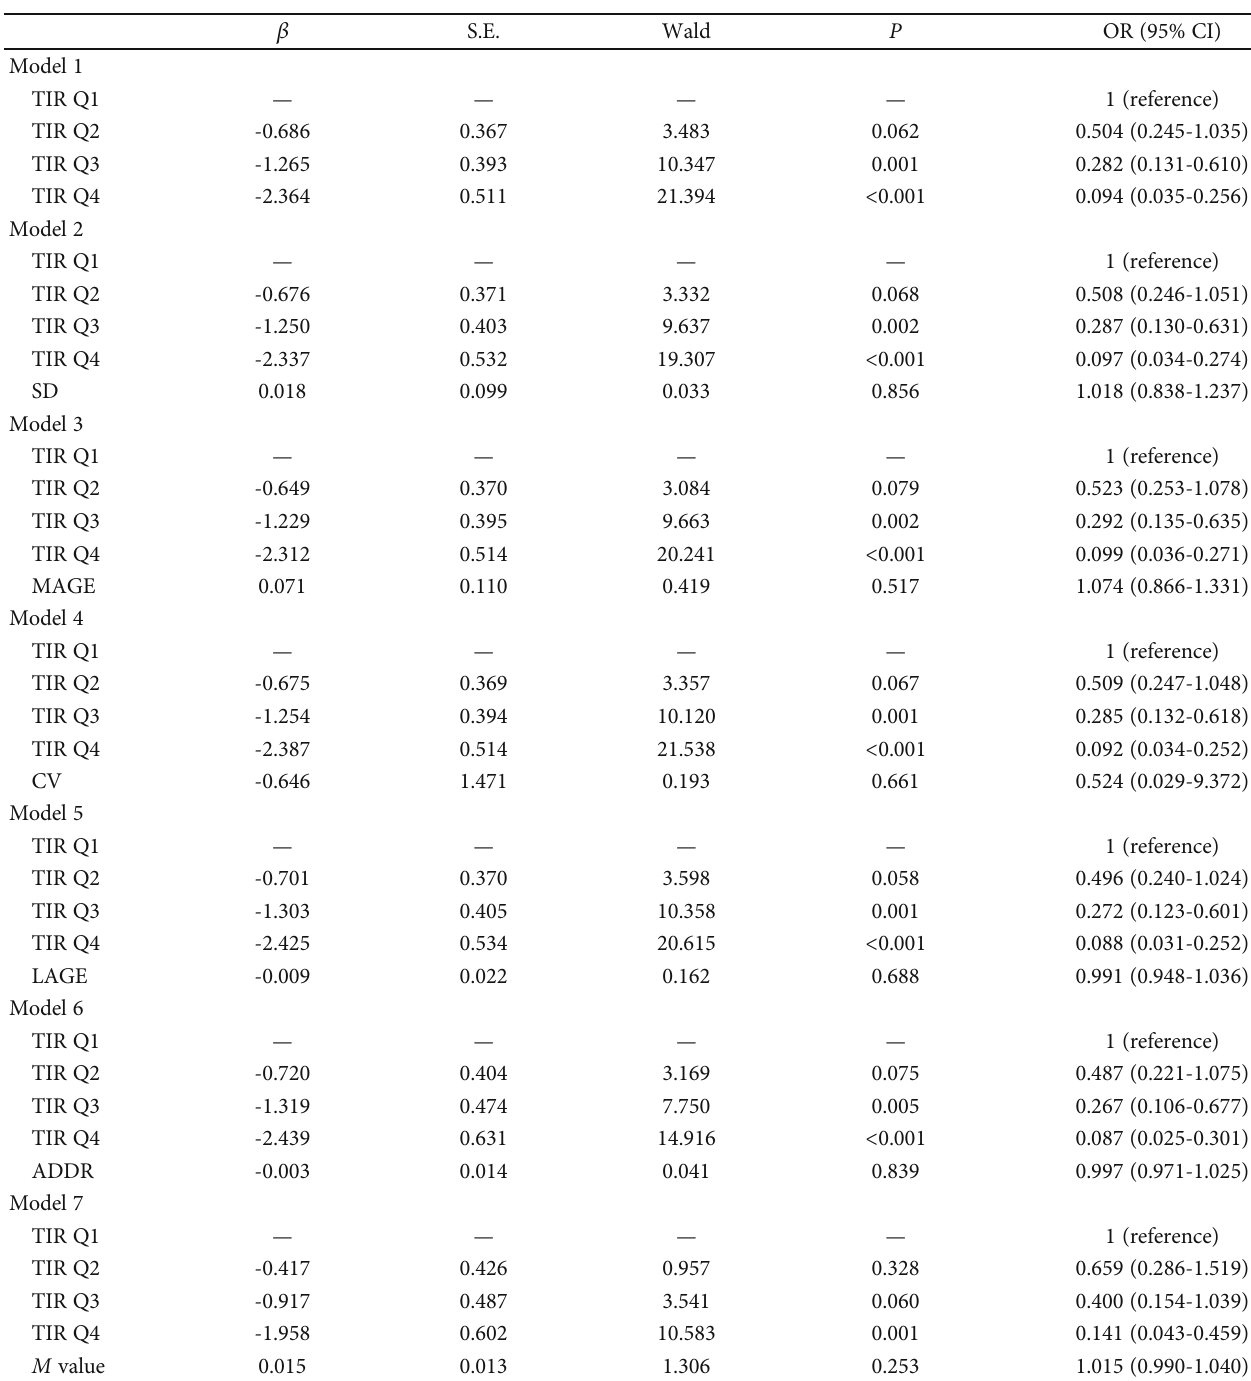
Table 5: Association between quartiles of TIR and